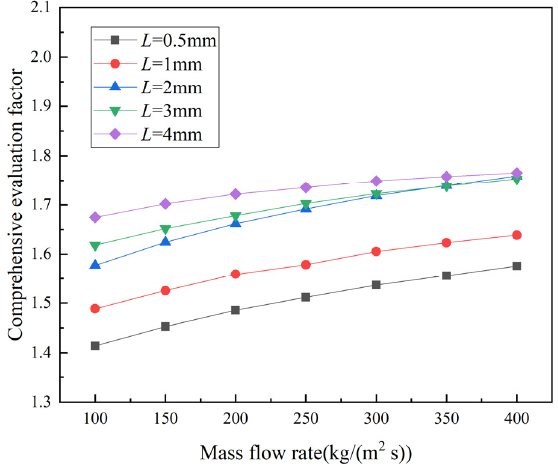
Figure 14. Comprehensive evaluation factor values of PCHEs at different mass flow rates for different offset distances of inserted straight sections.